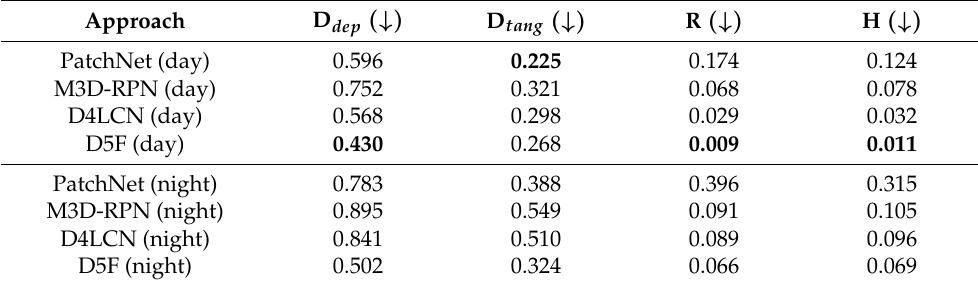
Table 8. MAE of radius ( R ), height ( H ), and location in depth ( D dep ) and tangential direction ( D tang ) of predicted cylinder by compared approaches. Errors are measured in meters. The best values are displayed in bold.